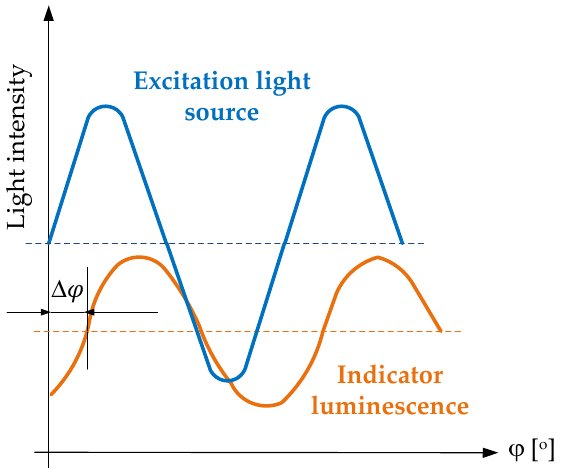
Figure 10. Basis of the method used for measuring the lifetime in the frequency domain.